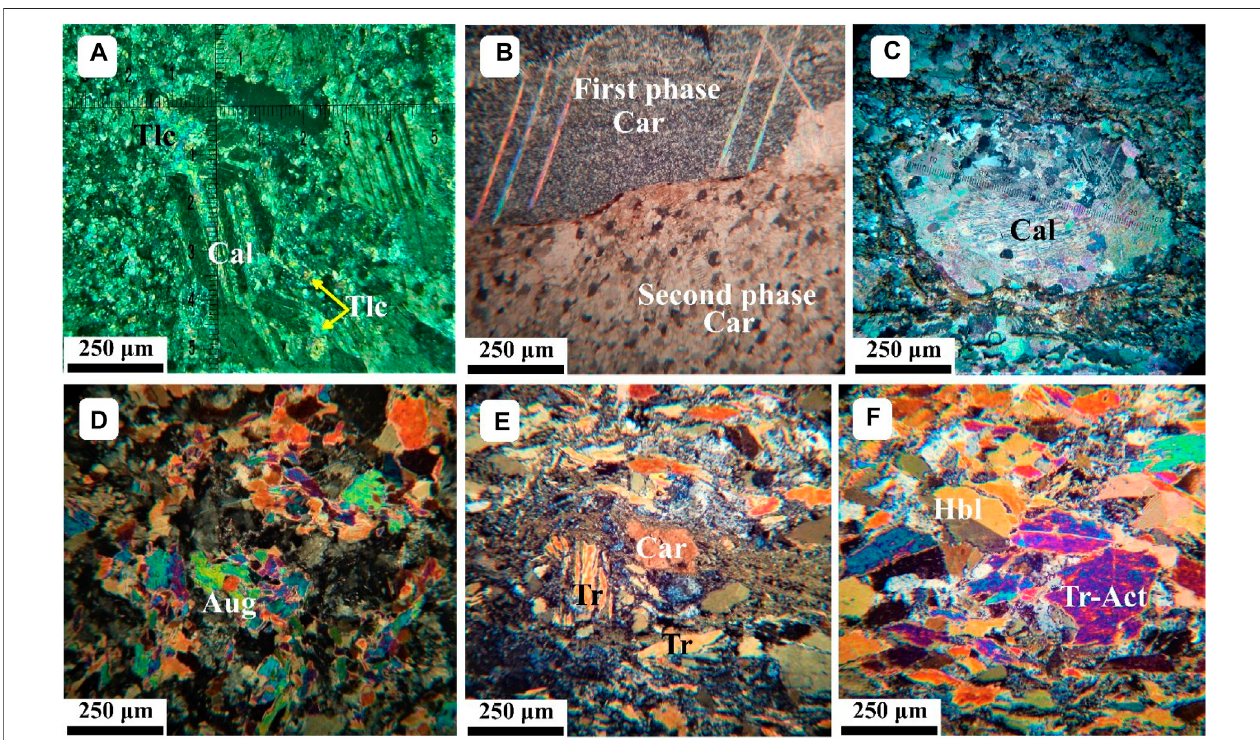
FIGURE 5 | Petrographical features of talc-carbonate, listwaenite, pyroxenite, and amphibolite rocks showing: (A) well-developed crystals of talc (Tlc) and calcite (Cal) crystals. C. N. (B) Showing two phases of carbonate deformation in listwaenite-like rock. C. N. (C) Mylonitization of larger carbonate (Car). C. N. (D) Green color augite (Aug)in pyroxenite rocks. C.N. (E) Sigmoid fi shofimmature carbonate (Car)and mylonitic texture inamphibolite. C.N. (F) Tremolite-actinolitecrystal (Tr-Act) and Baveno twinning of hornblende (Hbl). C. N.